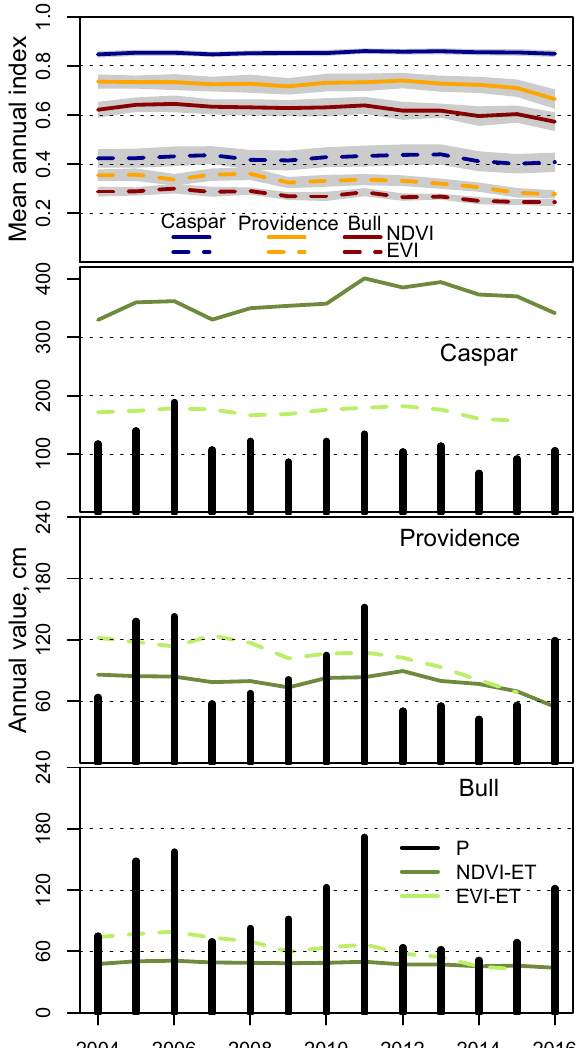
Figure 4. Mean annual vegetation indices used to calculate annual values of actual ET for the Caspar, Providence, and Bull sites. Vertical bars show observed annual precipitation recorded at the meteorological stations.